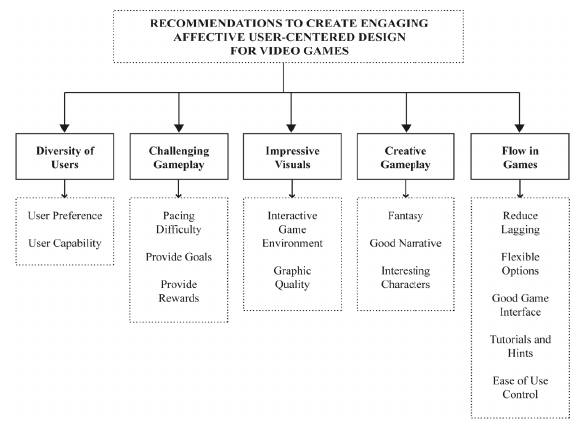
Figure 4: List of recommendations to create an engaging affective user-centered design for video